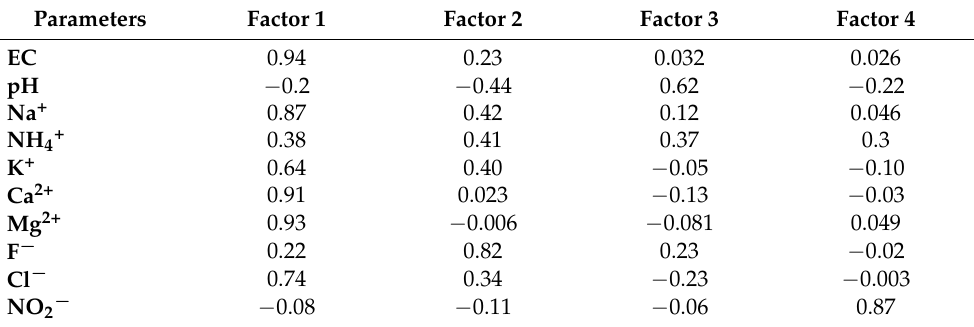
Table 5. Results of factor loading based on factor analysis of the samples in the Maku–Bazargan– Poldasht